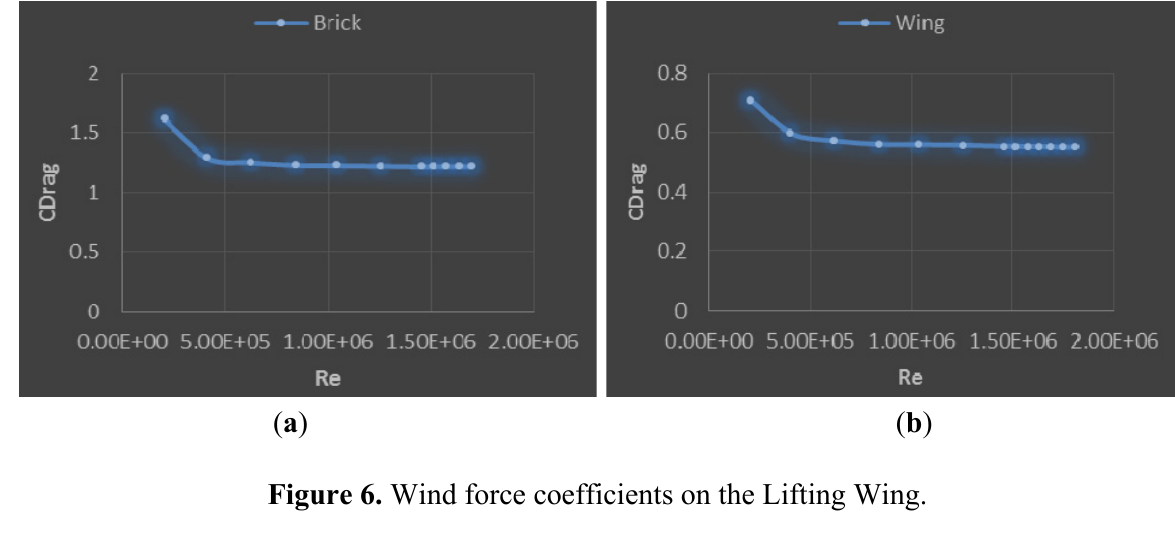
Figure 5. ( a ) Brick Re versus Cd; ( b ) Wing Re versus Cd.